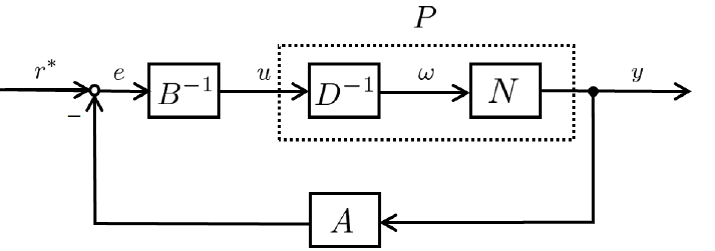
Figure 1. Nonlinear feedback system based on operator theory. Here, the plant P and operator controllers A , B − 1 are nonlinear, r ∗ is the reference input